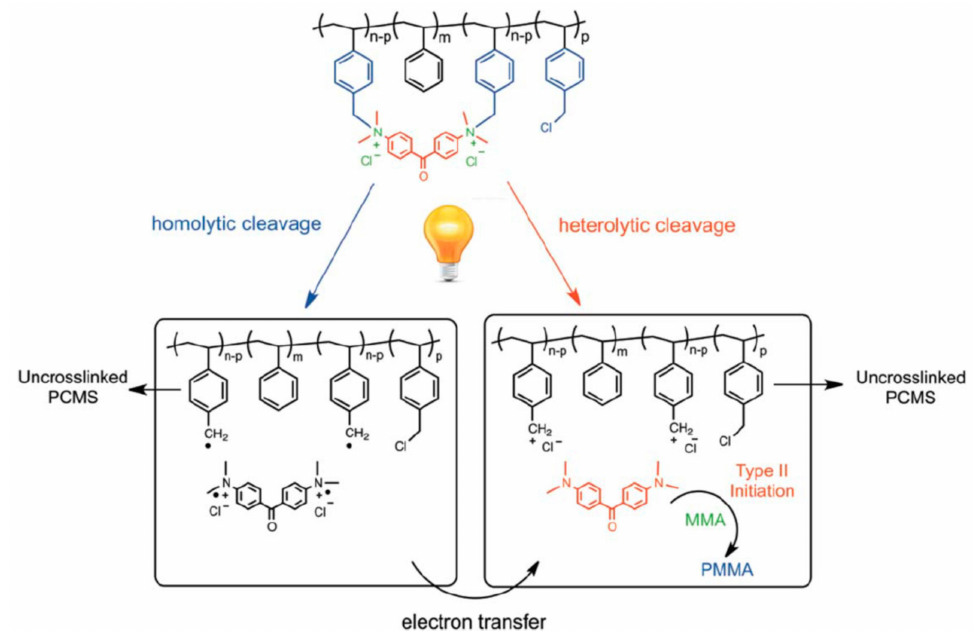
Figure 20. General mechanism of unfolding of SCNPs via phototriggered external cross-linker disassembly for SCNPs prepared from a polystyrene copolymer containing –CH 2 –Cl pendants (PCMS) using Michler (cid:48) s ketone as an external cross-linker, and concurrent photopolymerization of an MMA monomer by the released Michler (cid:48) s ketone units. Reprinted from [59] with